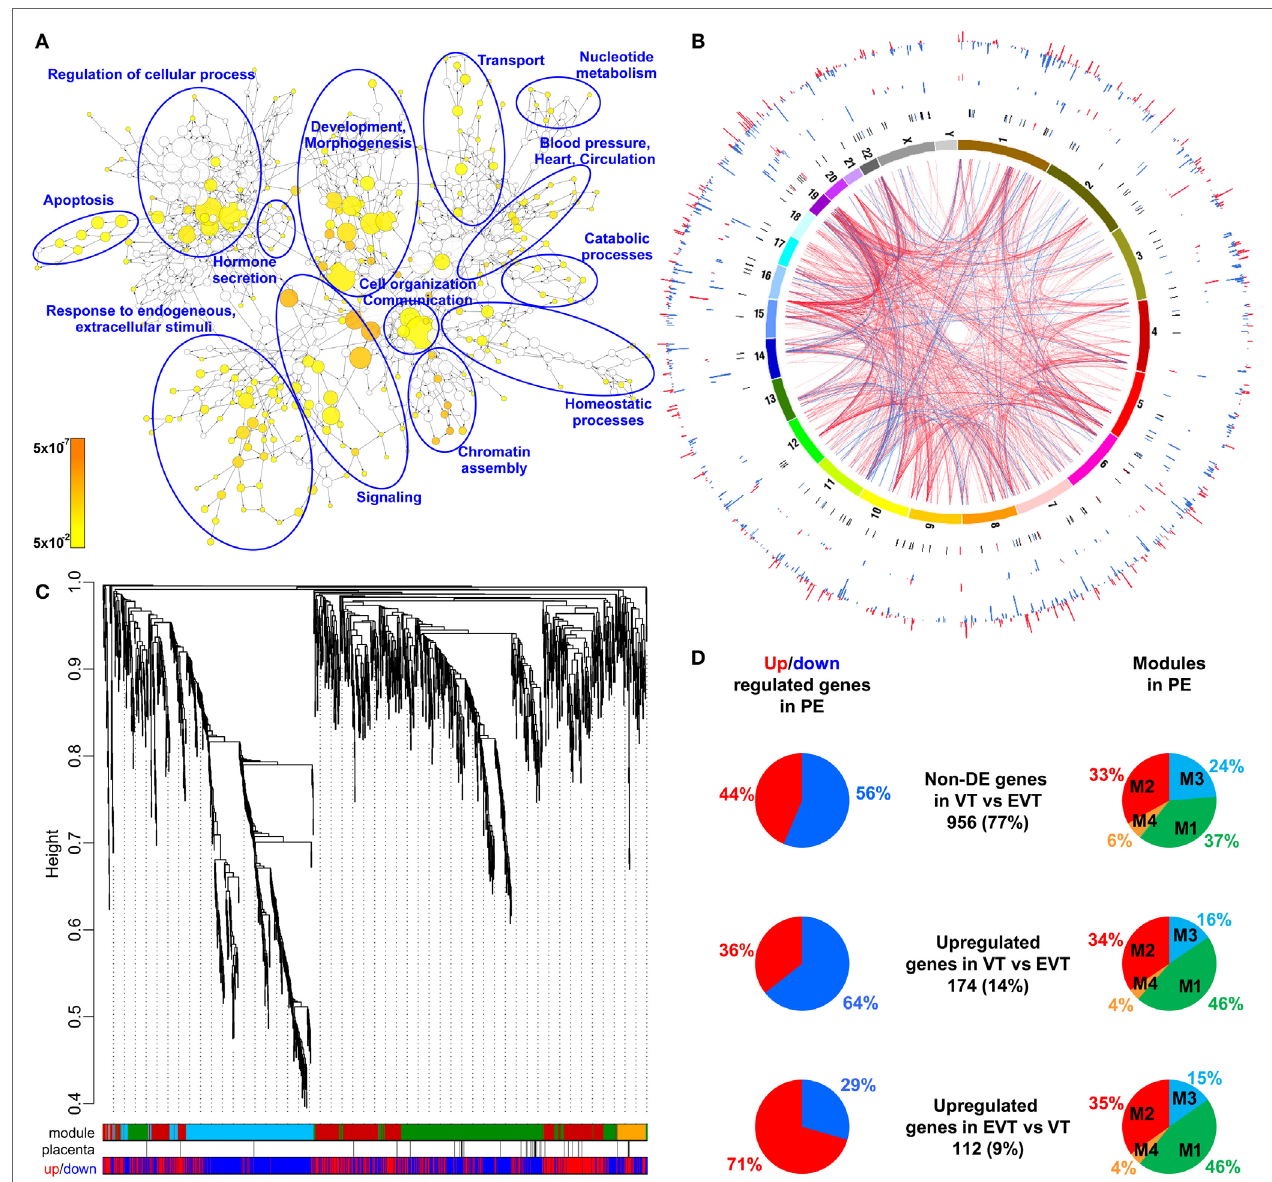
FigUre 3 | Placental transcriptomic changes in preterm preeclampsia. (a) The network of biological processes enriched among differentially expressed (DE) genes. Circle sizes relate to the number of genes involved in the biological processes; colors refer to p -values according to the color code. Groups of the most enriched biological processes were circled and labeled. (B) Circos visualization of DE genes in preterm preeclampsia (PE). The inner circle shows chromosomes; curved lines represent correlation (red: positive; blue: negative) between transcription regulatory genes and their targets; the second circle shows genomic location of predominantly placenta-expressed genes (black lines: non-DE; red or blue lines: up- or down-regulated); third and fourth circles show the locations of DE transcription regulatory genes and their targets, respectively with blue (down-regulated) and red (up-regulated) bars. The height of the bars represents the magnitude of expression changes. (c) Dysregulated placental gene expression was characterized by four major disease gene modules within DE genes, marked with different colors. The height plotted on the y -axis represents distance metric. Of 38 predominantly placenta-expressed genes (black vertical lines), 33 belonged to the M1 (green, n = 22) and M2 (red, n = 11) modules. These modules were enriched in predominantly placenta-expressed genes and enriched in up-regulated (M2) or down-regulated (M1) genes marked under the modules with red or blue lines, respectively. (D) Pie charts depict the distribution of three gene sets among dysregulated genes or gene modules. Genes with similar expression in villous (VT) and extravillous trophoblast (EVT) had similar distribution among up- or down-regulated genes and in modules M1 and M2. Genes with up-regulation in VT compared to EVT were predominantly down-regulated in preeclampsia and positioned in module M1. Genes with up-regulation in EVT compared to VT were predominantly up-regulated in preeclampsia and positioned also in module